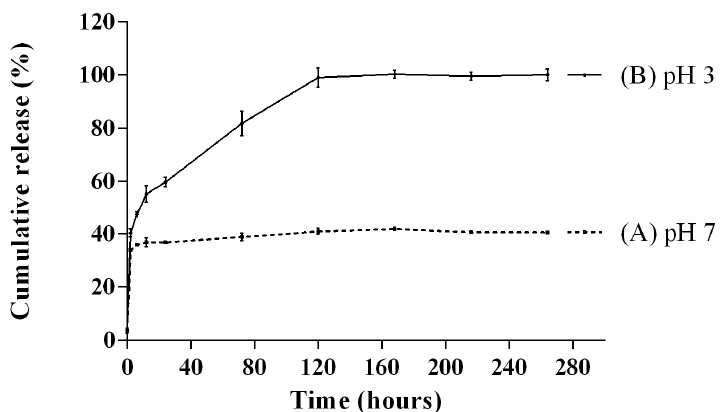
Figure 5. The release profile of BSP at pH 7 (A) and 3 (B) to mimic the condition of physiological environment and endosome/lysosome complex, respectively. At pH 7, BSP was released about 34% from BSP-HAP and no further BSP was released from BSP-HAP thereafter. When in pH 3, BSP-HAP was dissolved and BSP was released completely within the 5 th day ( n = 6).